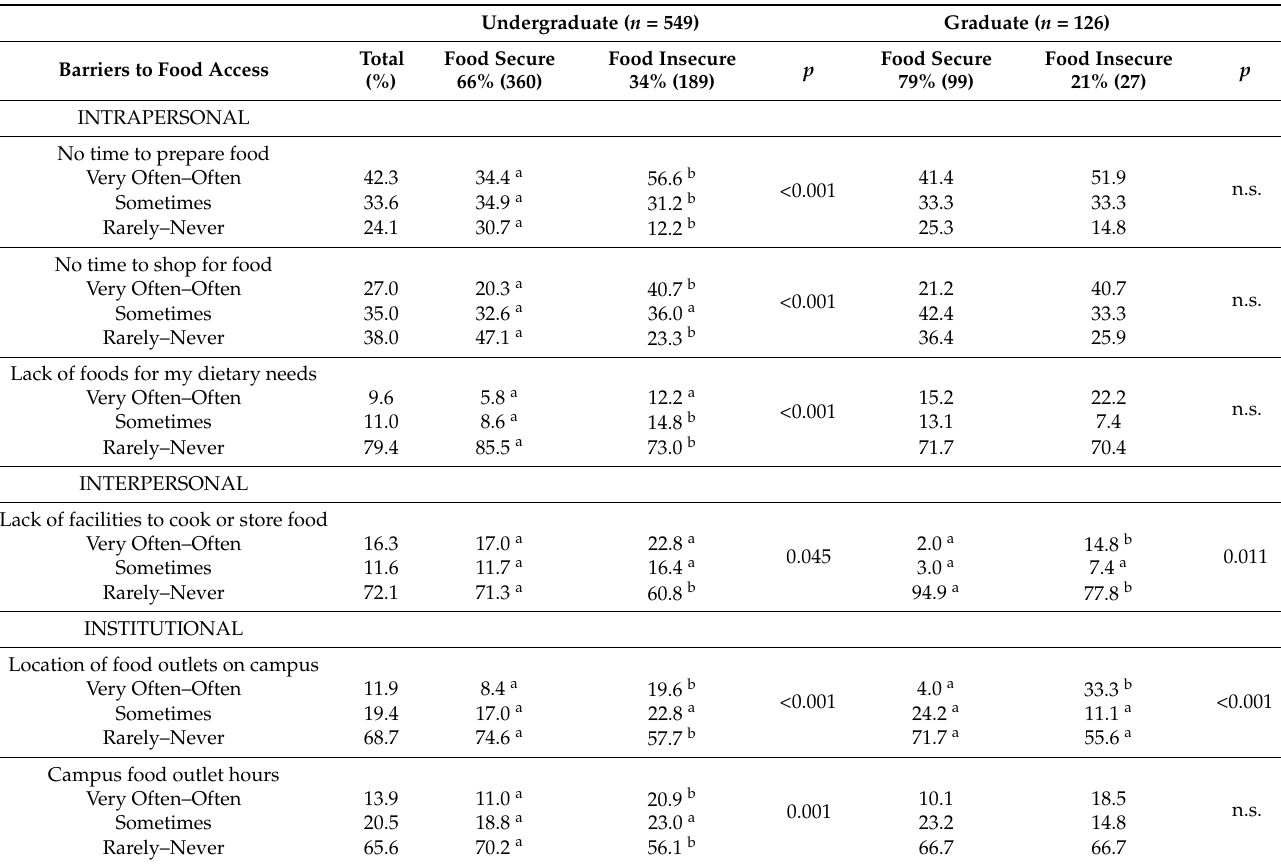
Table 2. Barriers to food access of midwest university students by academic and food security status 1